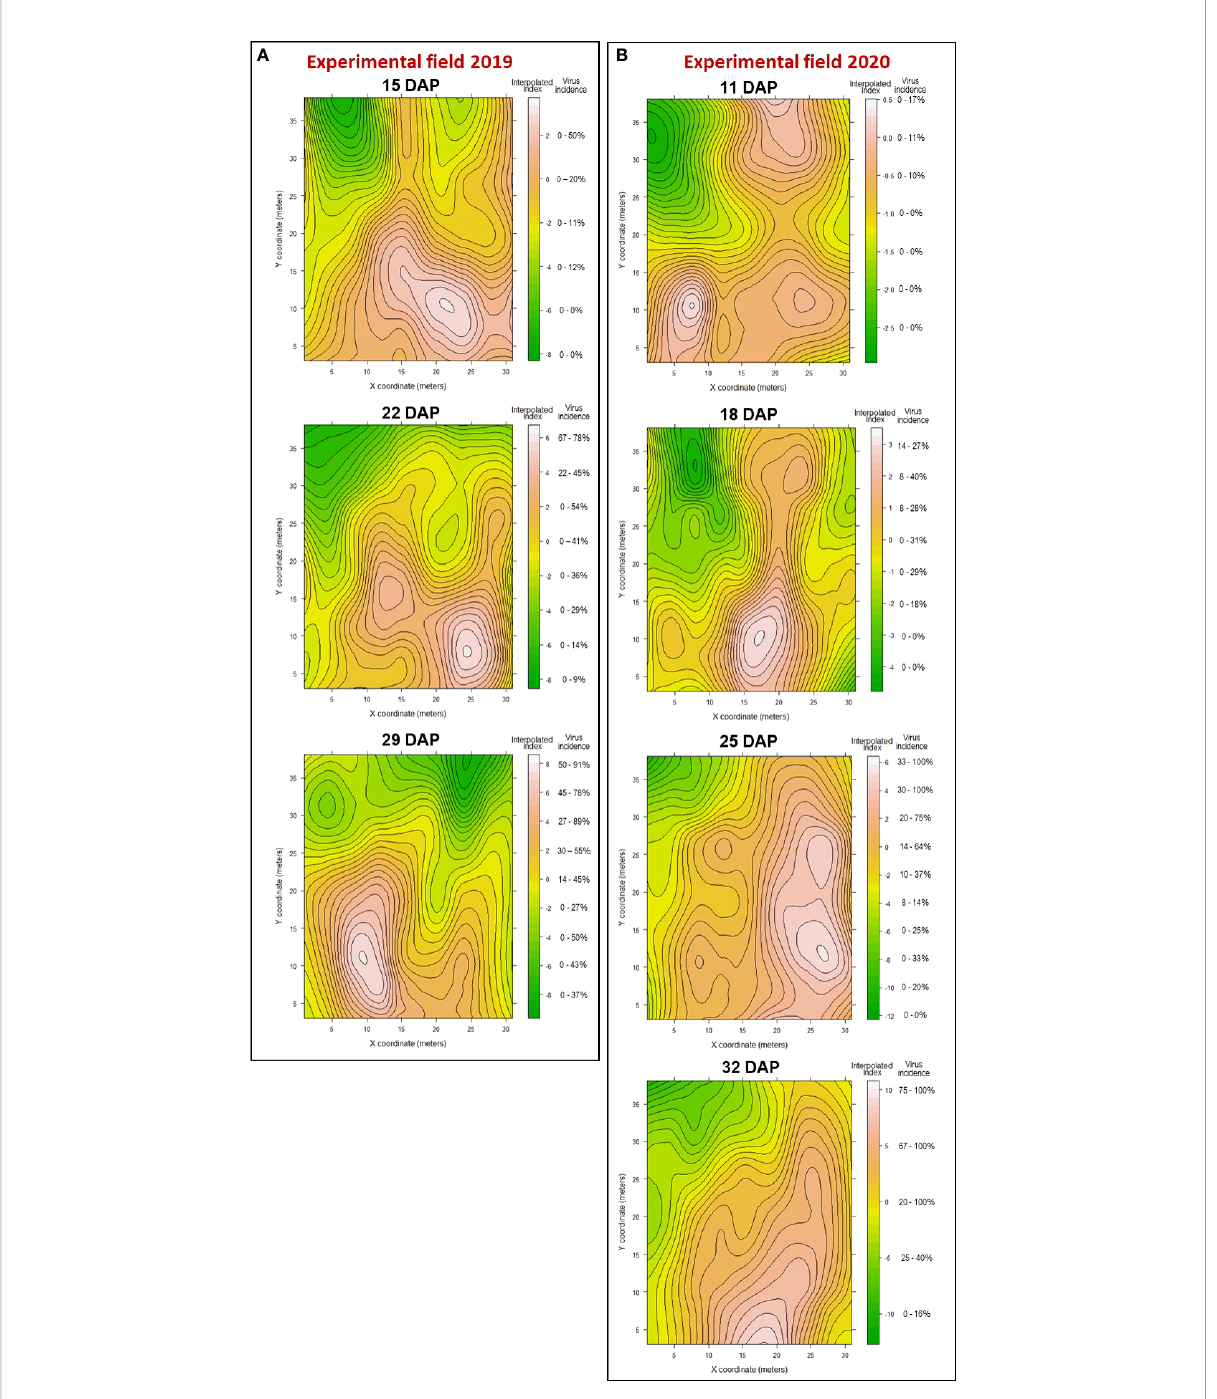
FIGURE 6 Contour maps of showing areas within the experimental fi eld, in 2019 (A) and 2020 (B) , where WTVC infected plants occurred as patches (red to white areas) or gaps (green areas) based on the interpolated index from the SADIE